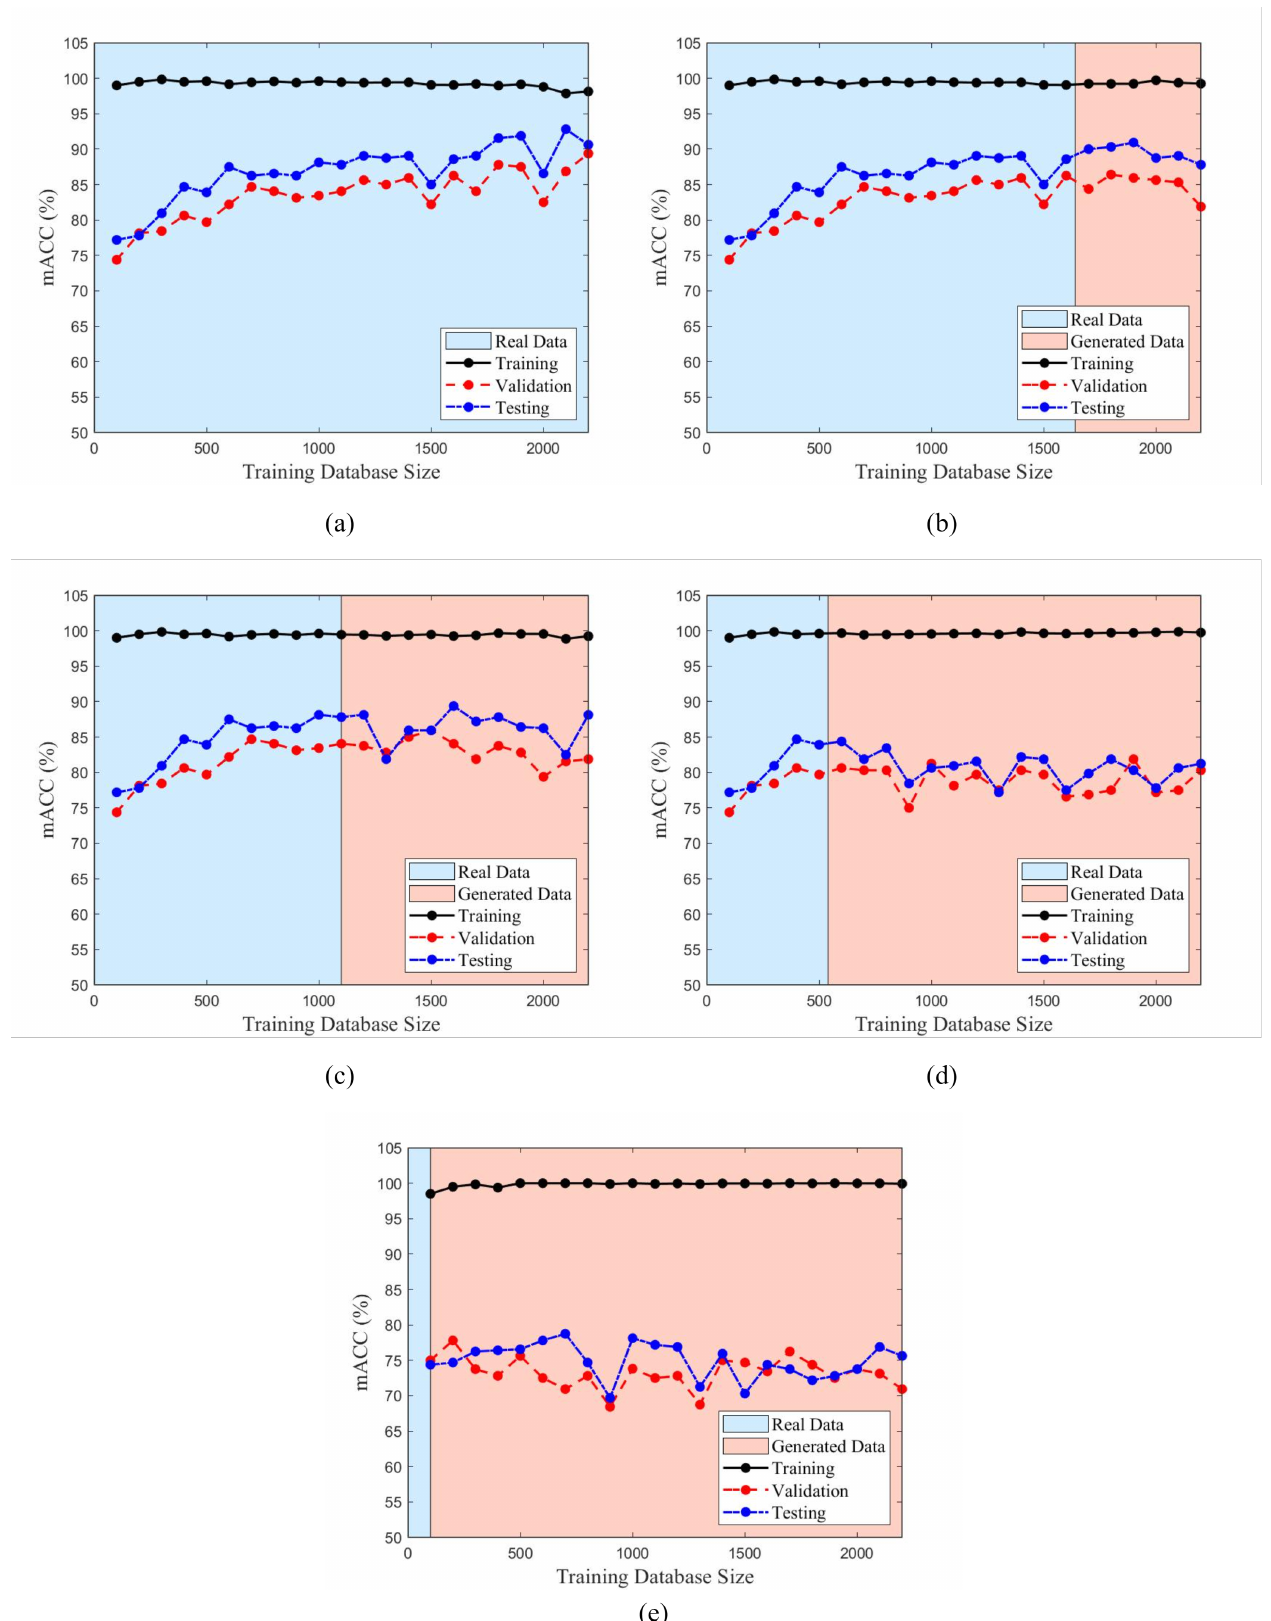
Figure 9. mACC of proposed CNN using different synthetic image ratios: ( a ) Scenario